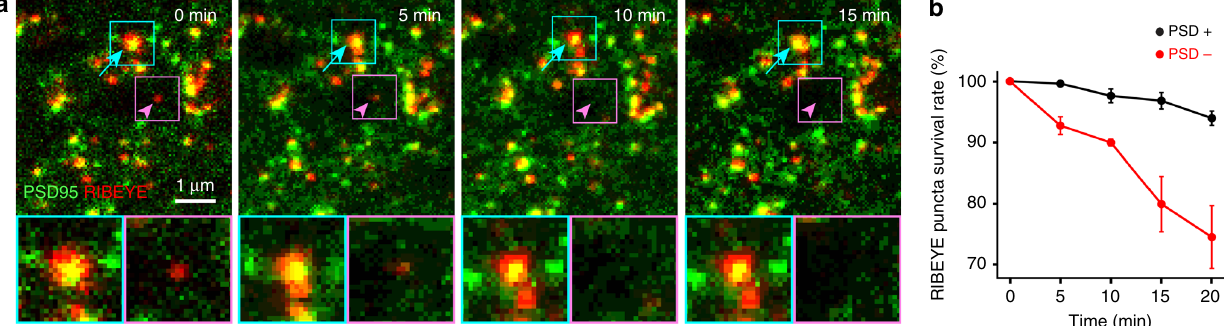
Fig. 4 RIBEYE puncta are more stable when apposed to PSD95-FP. a Monitoring ribbons and postsynaptic specialization (PSD95) simultaneously in a P10 retina from RIBEYE-tagRFP-T/PSD95-mVenus double transgenic mice by confocal microscopy. Shown here are the maximum intensity projections of image stacks that were acquired every 5 min up to 20 min. An example of a relatively stable RIBEYE-tagRFP-T punctum apposed to PSD95-mVenus punctum (arrow and cyan box) and an unstable RIBEYE-tagRFP-T punctum not apposed to PSD95-mVenus punctum (arrowhead and magenta box). b Survival rate of ribbon puncta apposed (PSD95 + ) or not apposed (PSD95 − ) to PSD95-mVenus puncta (three cells from three retinas). Data are presented as mean ± (Fig. 6a – e, two-tailed Mann – Whitney test: p = 0.429 for both P11 and P21). Also, synapse density between ON-alpha RGCs with